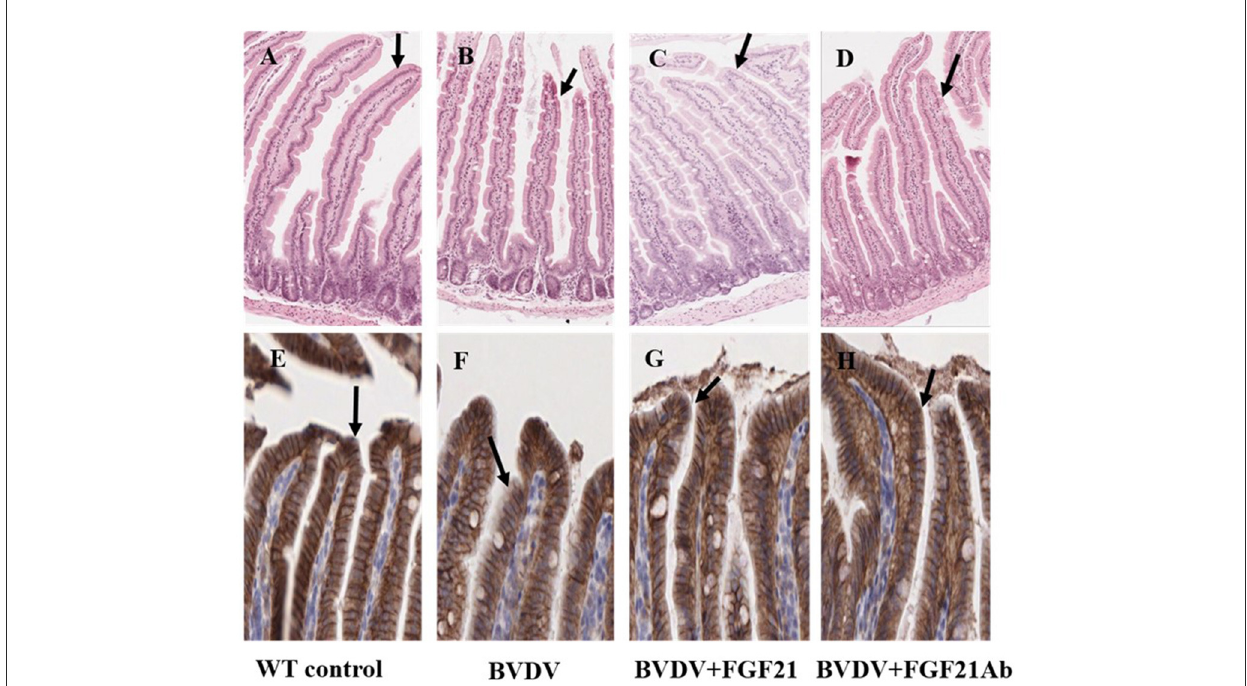
FIGURE5 Main pathological changes in the mice (H&E staining, × 100; E-cadherin staining, × 200). (A–D) H&E staining of duodenal epithelial cells in the control (A) , BVDV (B) , FGF21 (C) , and BVDV + FGF21Ab groups (D) . (E–H) E-cadherin staining of duodenum in the control (E) , BVDV (F) , FGF21 (G) , and BVDV + FGF21Ab groups (H)